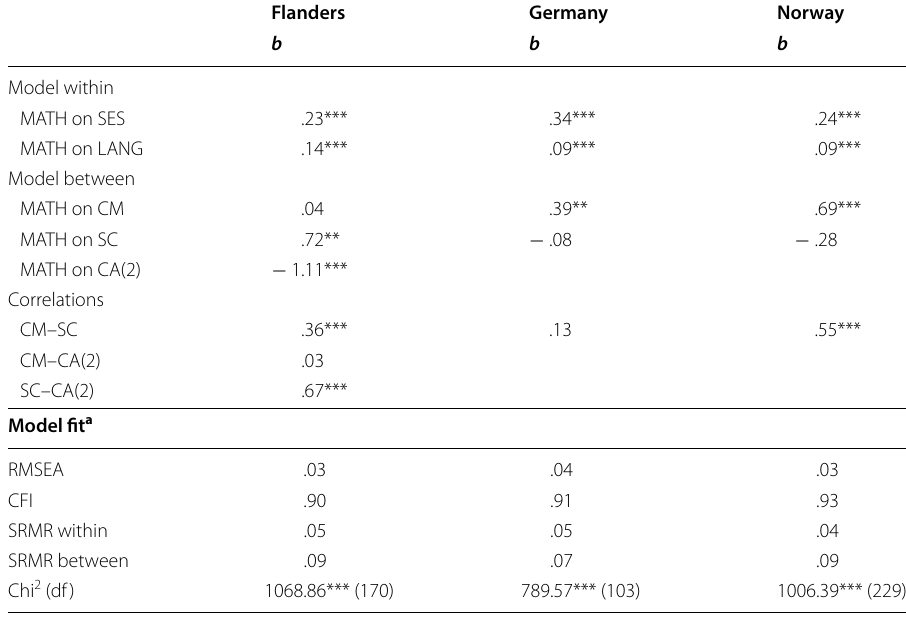
Table 7 Results direct relation between background characteristics and achievement